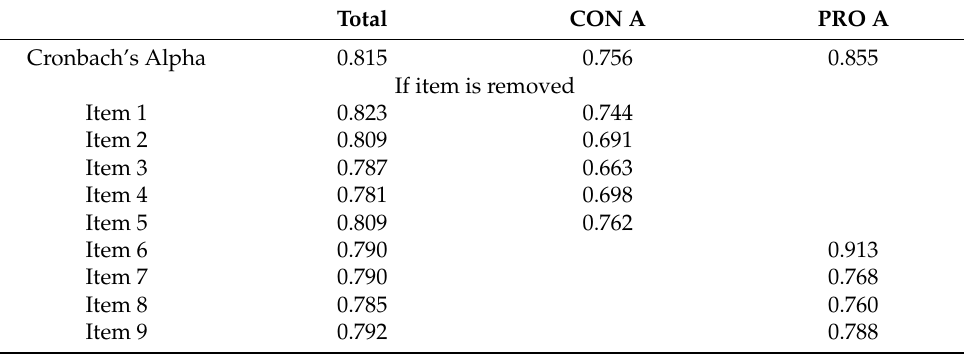
Table 5. Cronbach’s alpha and Cronbach’s alpha if the item is removed.